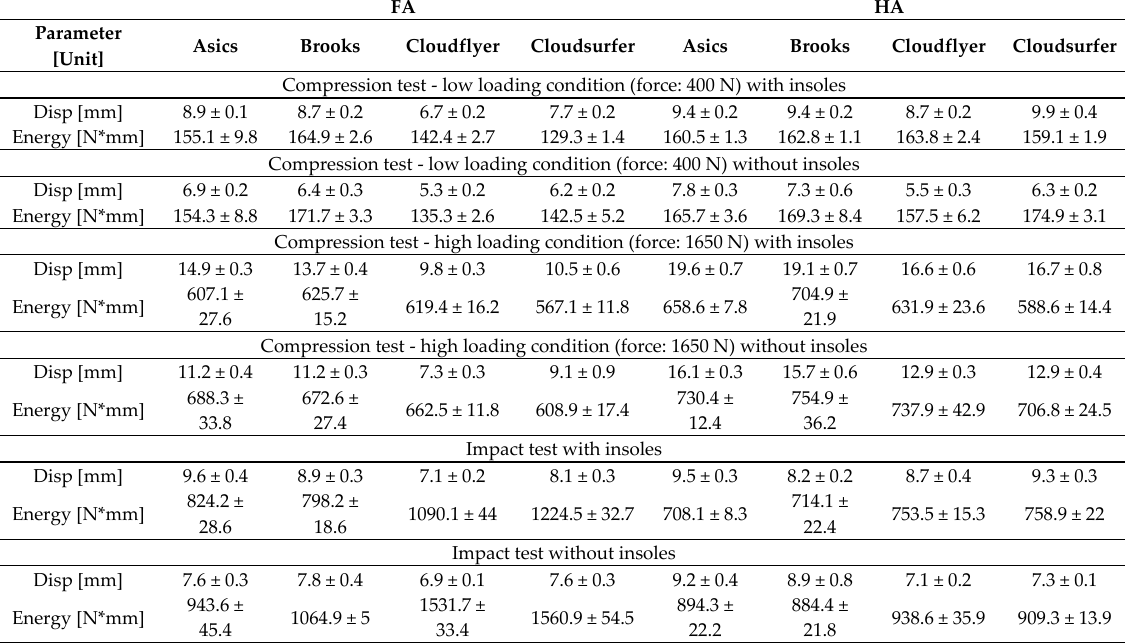
Table 2. Measured Disp and calculated energy for all material tests (MATs) with the four running